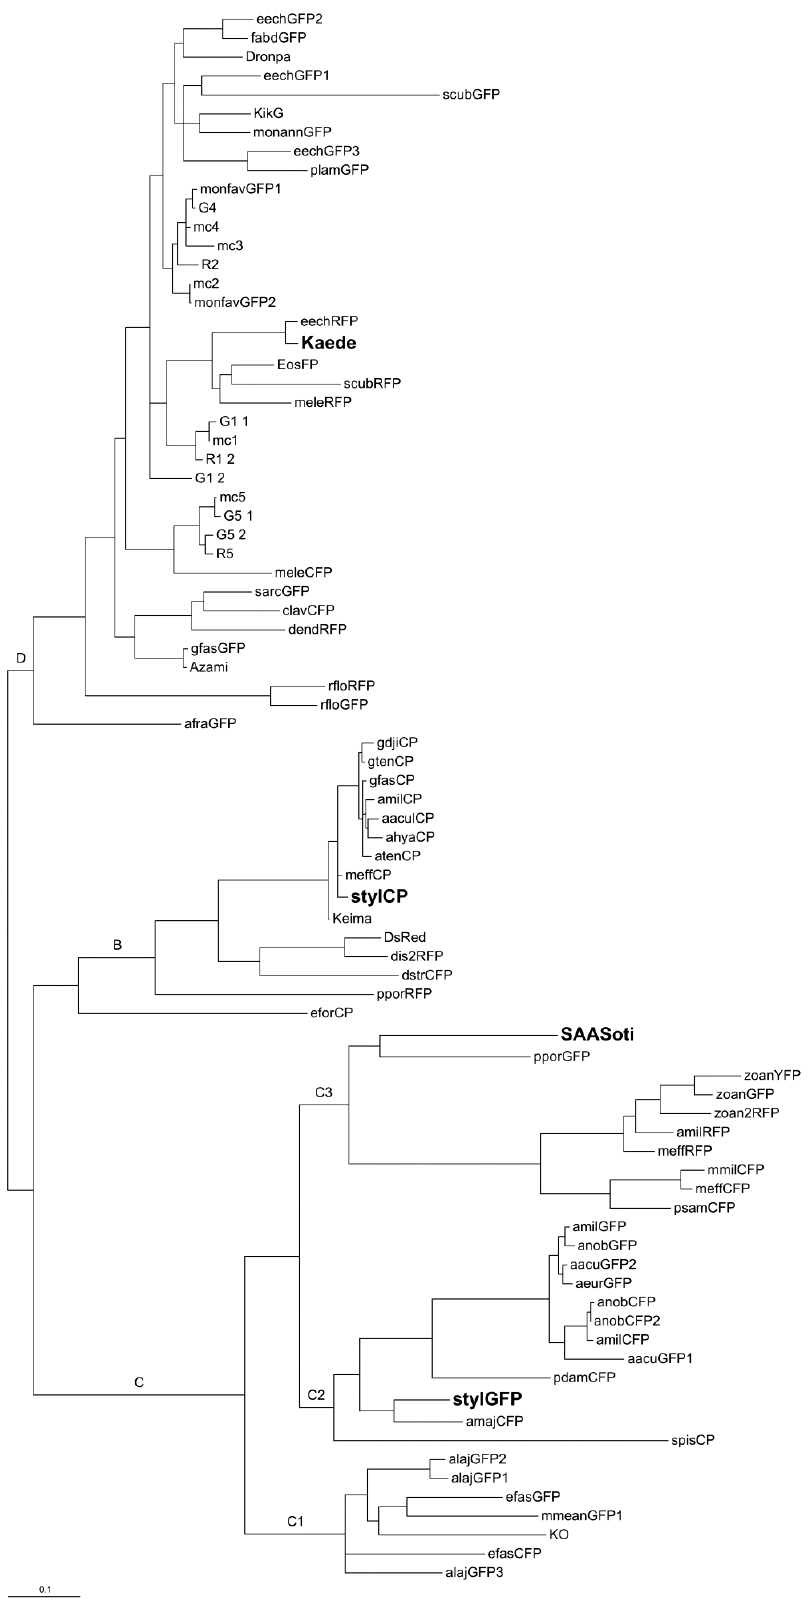
Fig. 7. Bayesian phylogenetic tree of coral sourced FPs. Genes of interest are contrasted with bold font. Clades and subclades coded by